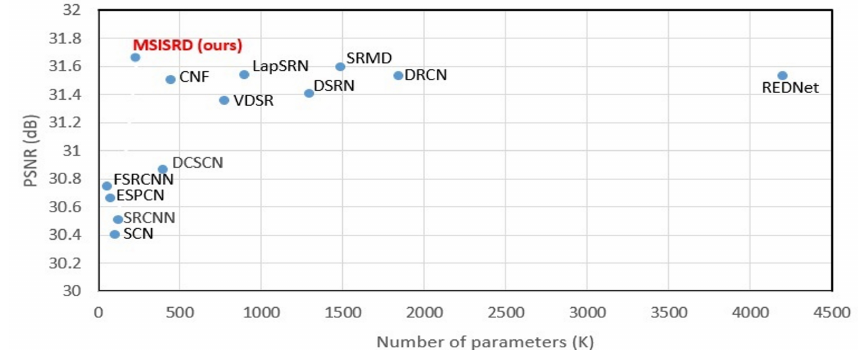
Figure 5. The model complexity comparison in number of parameters versus PSNR [56]. The performance of model complexity are evaluated on Set5 [56] dataset for 4 × SR [67].